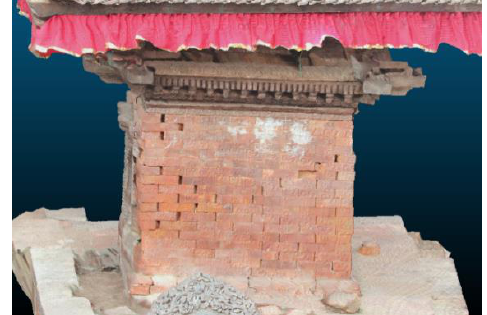
Figure 5. Model of a temple with cracks induced by